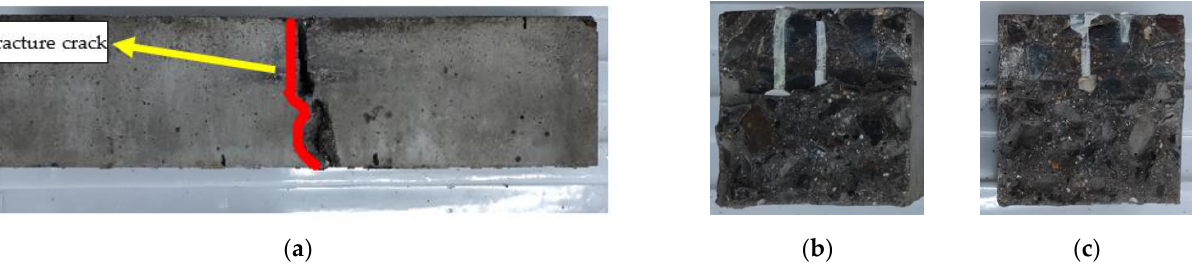
Figure 22. Failure mode of URFSI-400: ( a ) side surface; ( b ) fracture surface 1; and ( c ) fracture surface 2.